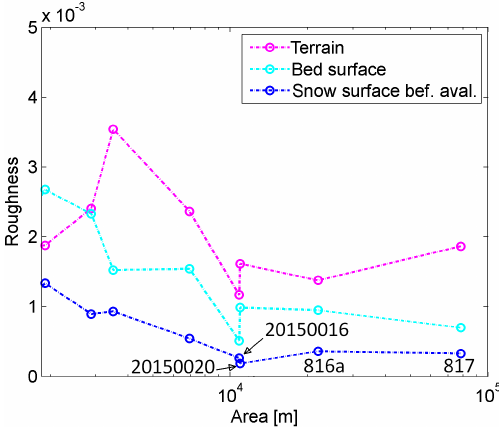
Figure 7. Release area size as a function of its surface roughness at the level of the snow-free terrain (red), the bed surface (light blue) and the snow surface prior to avalanche release (dark